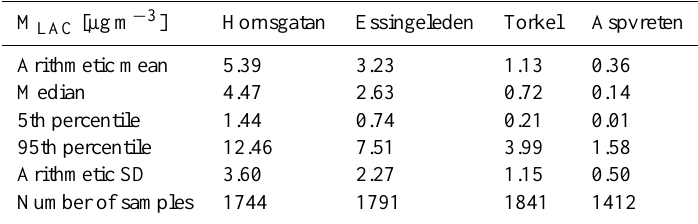
Table 1. Descriptive statistics of hourly M LAC concentrations at the four sites for the period 20 April–5 July 2006.